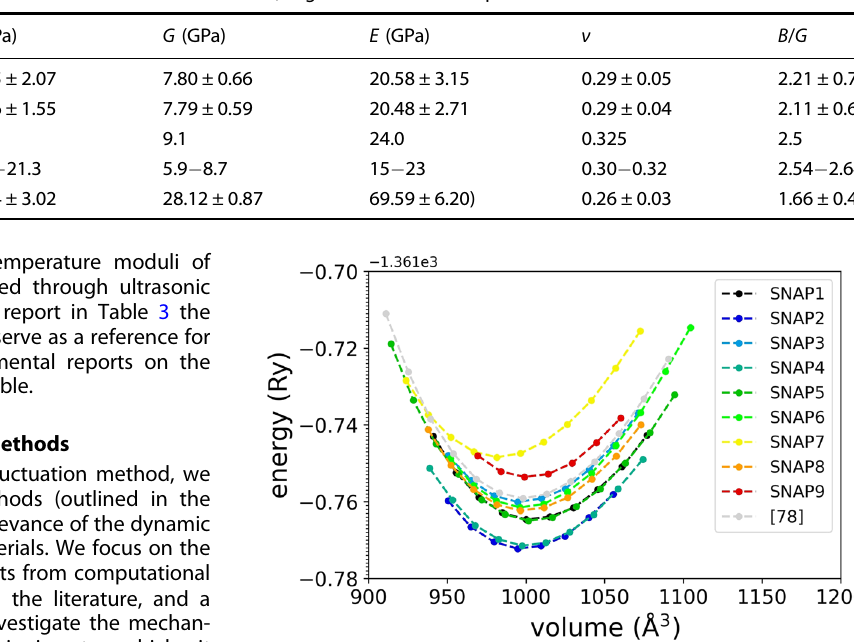
Table 3. 0 K and room-temperature extrapolations, following a Wachtman ’ s fi t, of bulk, shear, Young ’ s modulus, and Poisson ’ s ratio from NPT CP molecular dynamics and the strain- fl uctuation method for t-LGPS and o-LGPO, together with some experimental results 93,94 .